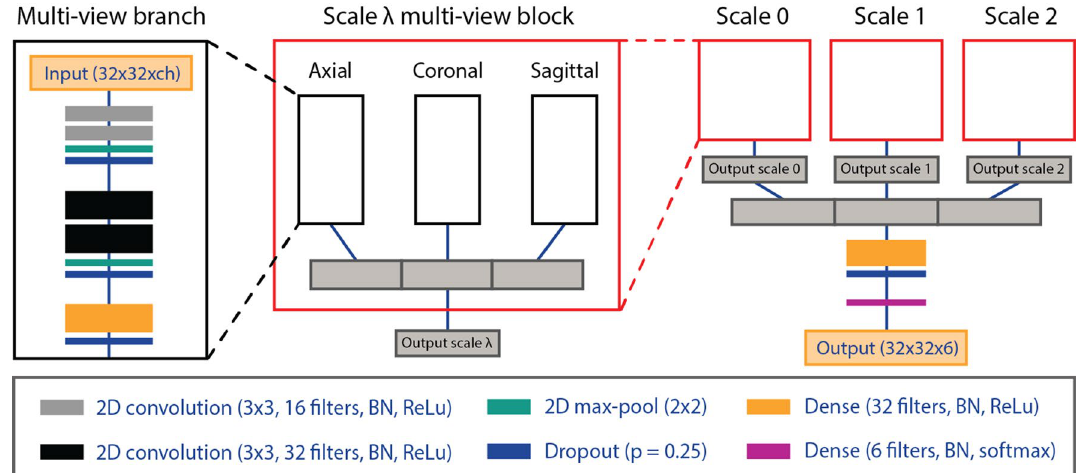
Figure 1. Schematic representation of the multi-view convolutional neural network (MV-CNN) architecture. Three multi-view branches build up each anatomical plane within a scale block. The output of which is concatenated and used as input for the multi-scale branched architecture. Batch normalization is always applied before the non-linear activation function. Thickness of convolutional and dense blocks correspond with the number of filters used. ch number of channels; λ scale; BN batch normalization; ReLu rectified linear unit. Figure was generated with Adobe Illustrator (version 16.0.0; https:// www. adobe. com/ creat ivecl oud.